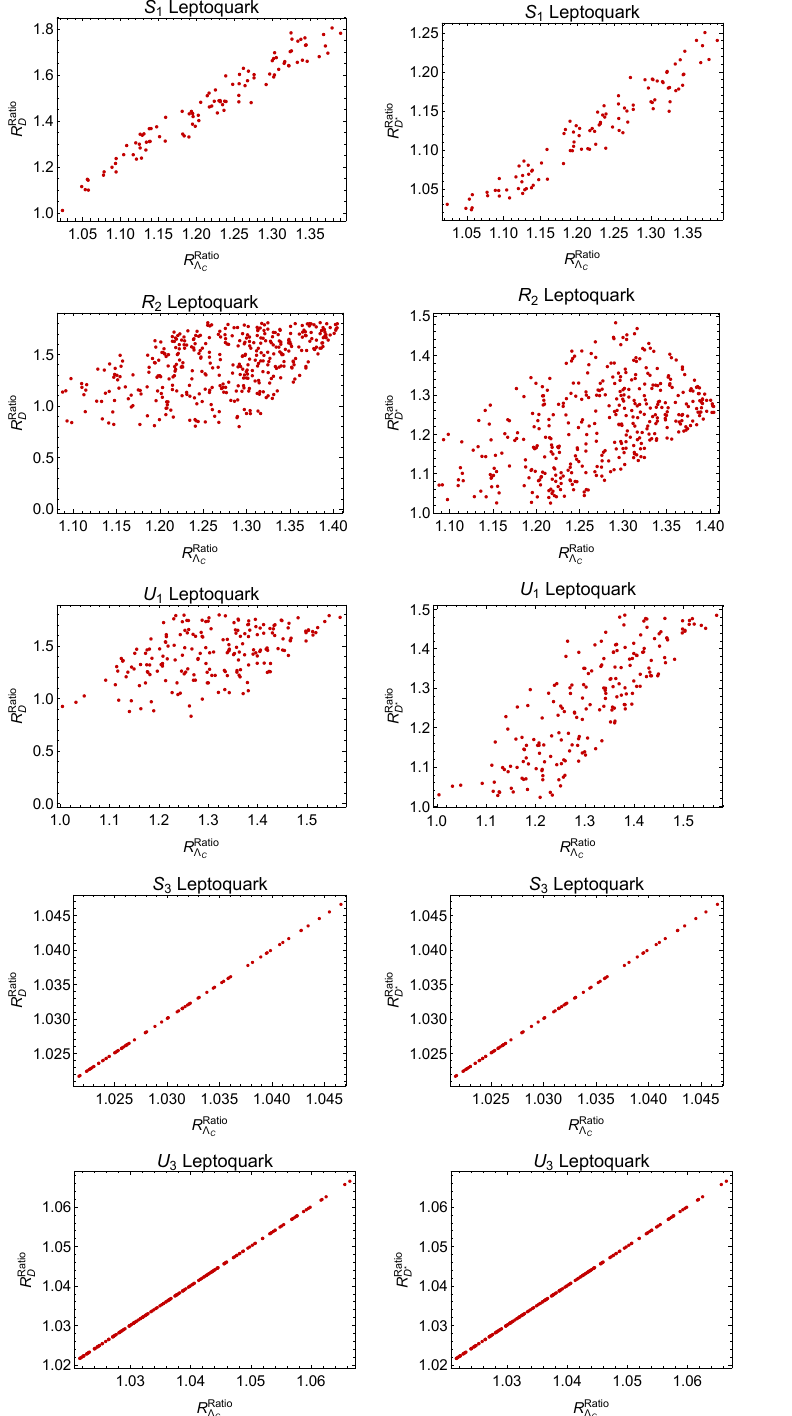
Figure 12 . The allowed regions in the R Ratio model, given the allowed regions for the couplings from figures 10 and